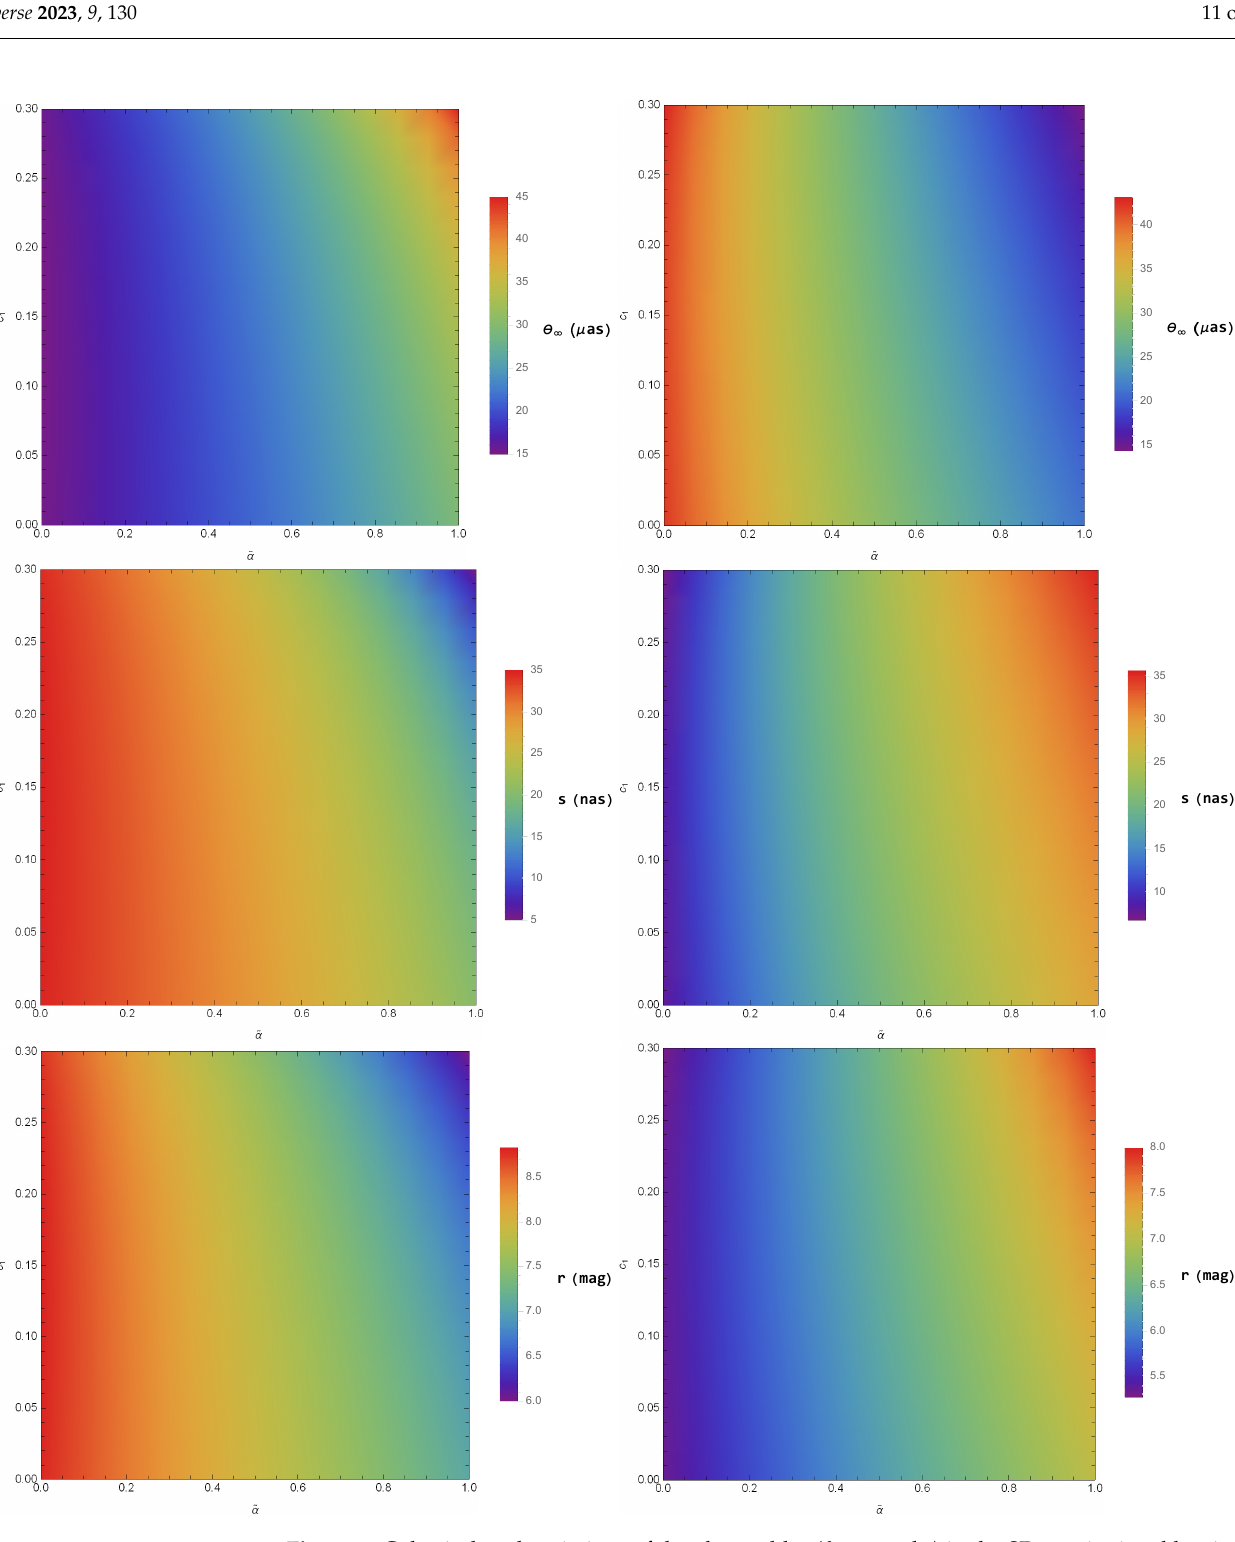
Figure 5. Color-indexed variations of the observables ( θ ∞ , s , and r ) in the SD gravitational lensing in the conformal gravity BH from that of a Schwarzschild one for SgrA ∗ ( left ) for PPL and ( right ) for PPM with ˜ α and c 1